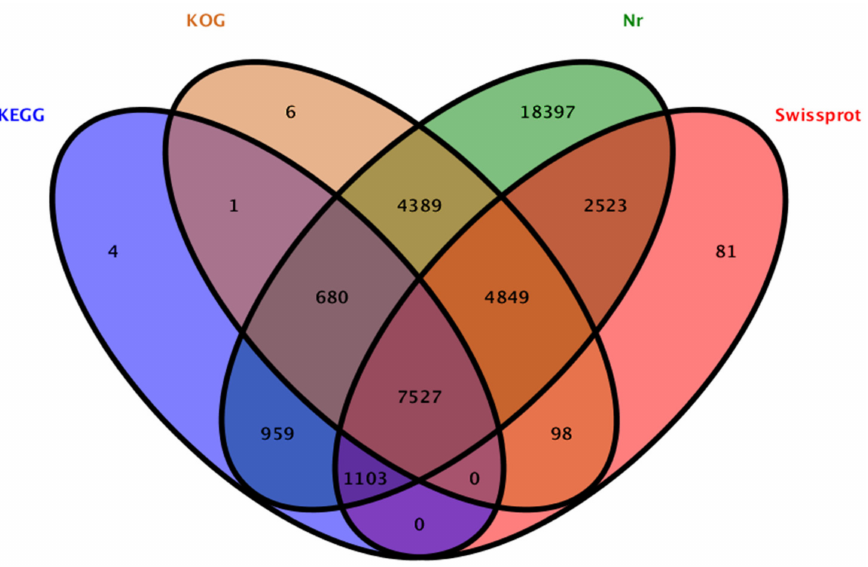
Figure 4. Basic annotation for all unigenes in C. songaricum on KEGG, KOG, Nr and Swissprot